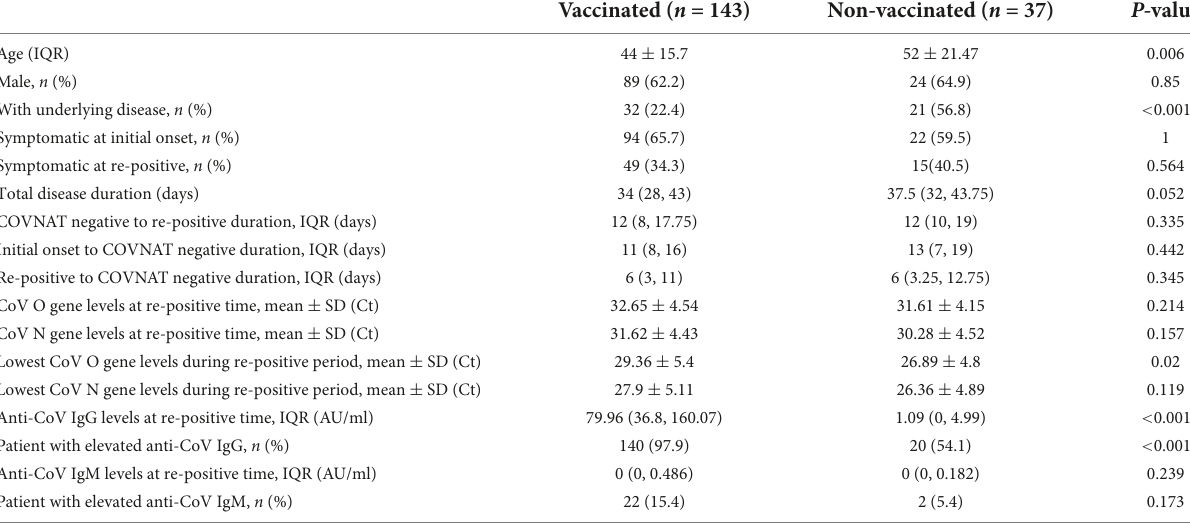
TABLE 4 Comparison of clinical characteristics and laboratory results between vaccinated and non-vaccinated